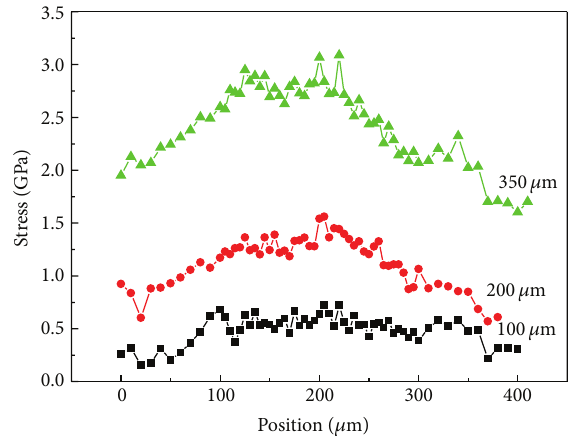
Figure 10: Stress distributions on the bridging fiber under different loads [16].